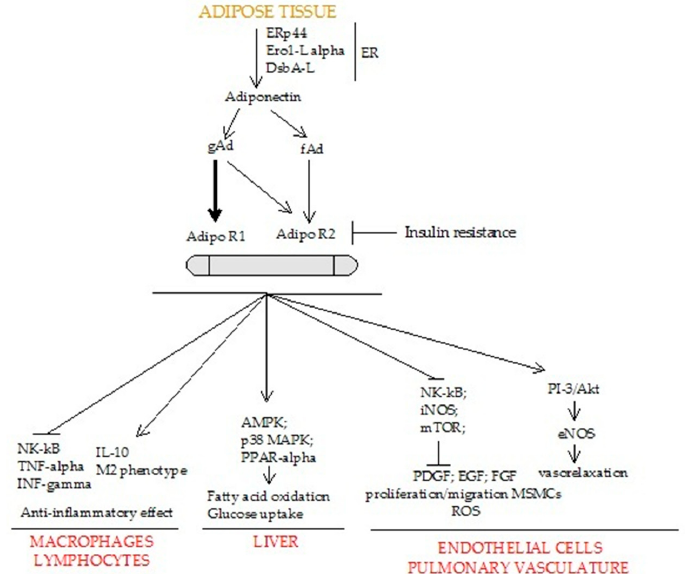
Figure 1. Cascade of cellular biological signaling activated by adiponectin – AdipoR1/R2